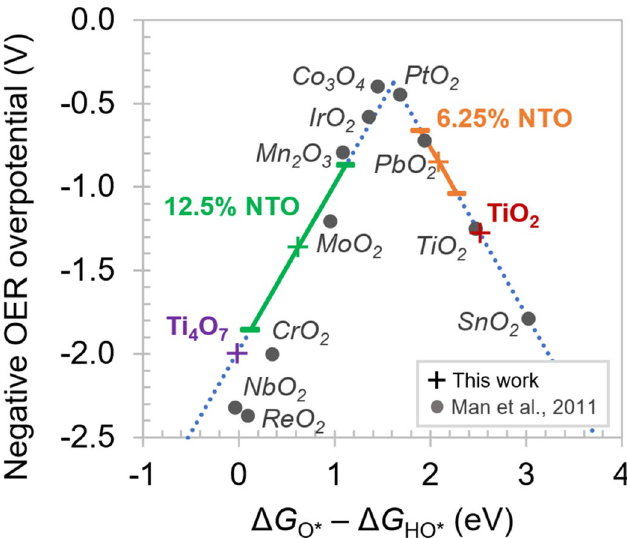
Figure 1. Predicted trends in oxygen evolution overpotential relative to SHE based on DFT calculations. Higher loadings of Nb-doped TiO 2 (NTO) lead to reduction of the critical descriptor (cid:31) G O ∗ − (cid:31) G HO ∗ compared to pure rutile TiO 2 . This corresponds to an initial decrease in the magnitude of the OER overpotential prior to increasing again. The suppressed OER activity of 12.5 at.% NTO is predicted to approach that of Ti 4 O 7 , which was shown previously as a candidate for PFAS destruction.